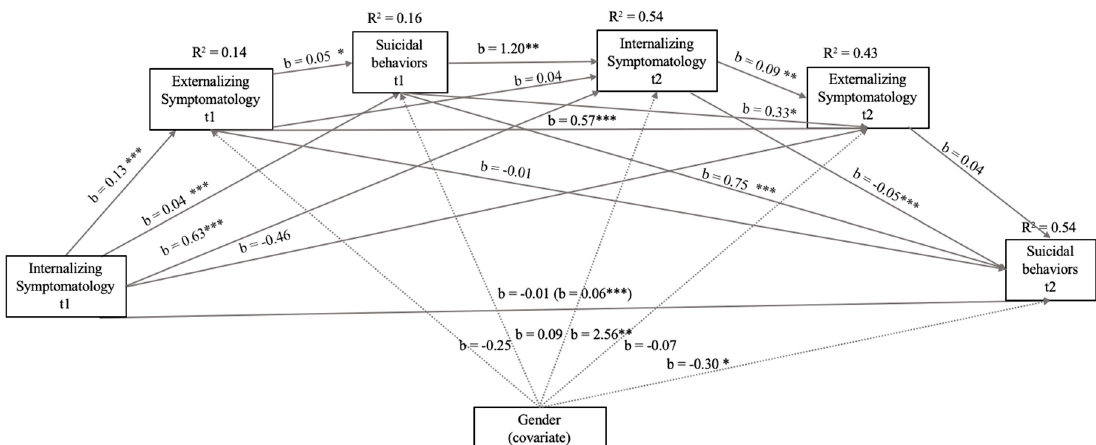
Figure 1. Model of mediation of the relations between Internalizing Symptomatology (t1) through Internalizing Symptomatology (t2), Suicide Behaviors (t1 and t2), Externalizing Symptomatology (t1 and t2), and Suicide Behaviors (t1) with Suicide Behaviors (t2) after controlling for gender (girl). In this statistical diagram, values are represented with non-standardized regression coefficients. In the association between Internalizing Symptomatology t1 and Suicide Behaviors t2, the value outside parentheses represents the direct effect, and the value in parentheses represents the total effect of the bootstrapping analysis of Internalizing Symptomatology t1 on Suicide Behaviors t2 after the inclusion of mediation variables. *** p < 0.001, ** p < 0.01, * p < 0.05.